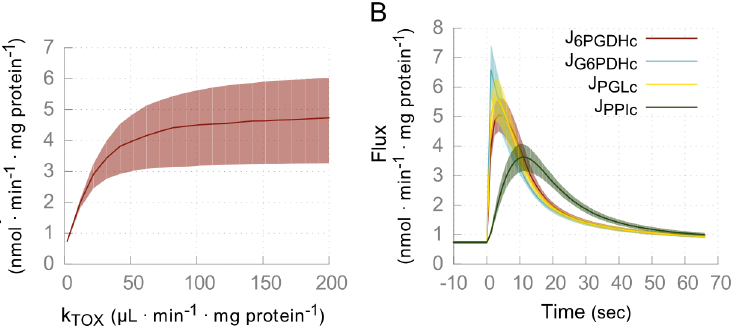
Figure 4. Simulations of oxidative stress in model C. ( A ) The steady state flux through the cytosolic pentose phosphate pathway in model C as a function of the oxidative stress by varying the kinetic constant k TOX . ( B ) Fluxes through the cytosolic PPP enzymes as a function of time upon sudden oxidative stress. During the whole time-course, k TOX =2 m l ? min 2 1 ? mg protein 2 1 . The system is removed from steady state at t =0, by setting 99% of the NAD(P)H and trypanothione pools to the oxidized form. Shown is the relaxation of the cytosolic PPP fluxes. Solid lines indicate medians, shaded areas show interquartile ranges. Near identical results were obtained for model D (Figure S5).